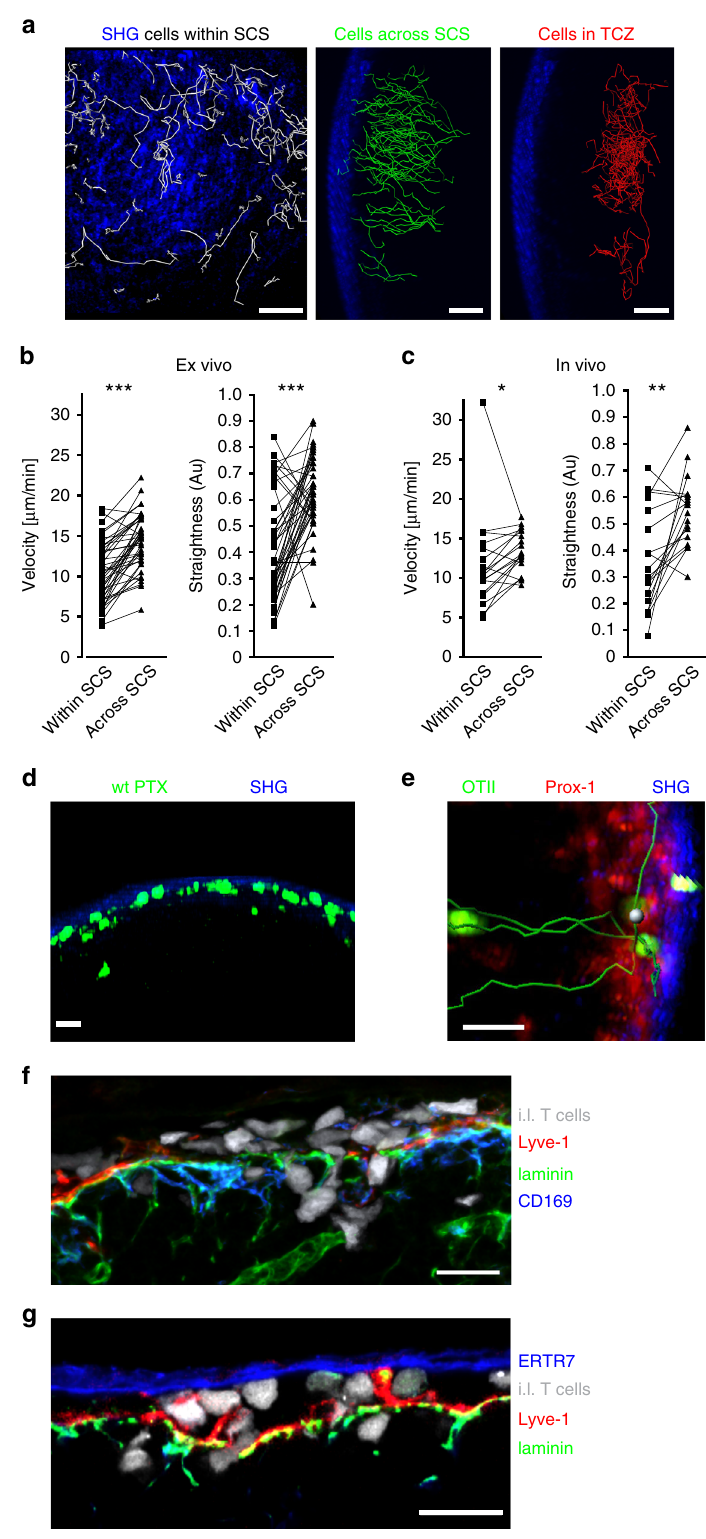
CD4 T cells move along and through sinus endothelial cells . To further study molecular mechanisms that allow ald T cells to translocate from the SCS into the LN parenchyma, we applied in vivo and ex vivo 2PM. After arrival within the SCS, ald T cells were regularly found to crawl with an average speed of approximately 12 μ m/min on endothelial cells of the sinus fl oor,